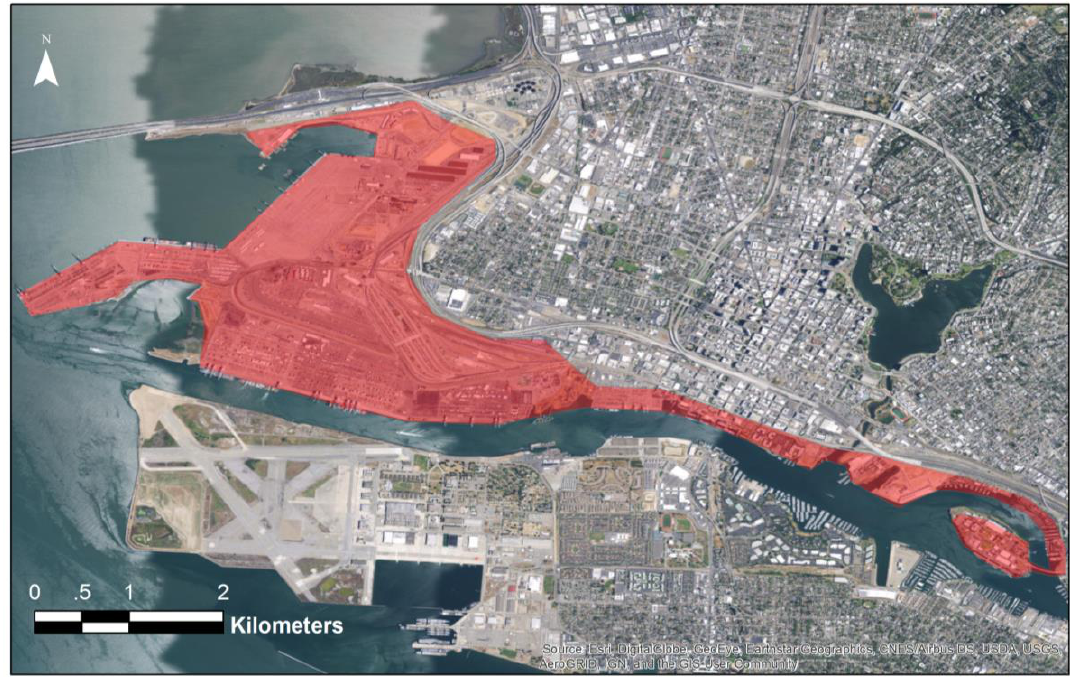
Figure 4. Example of a port polygon (Oakland, CA) determined manually using satellite imagery available from ESRI (Sources: ESRI, DigitalGlobe, GeoEye, Earthstar Geographics, CNES/Airbus DS, USDA, USGS, AeroGRID, IGN, and the GIS User Community). Table 7. Number of ports and port areas (in square kilometers) in each region of the US.